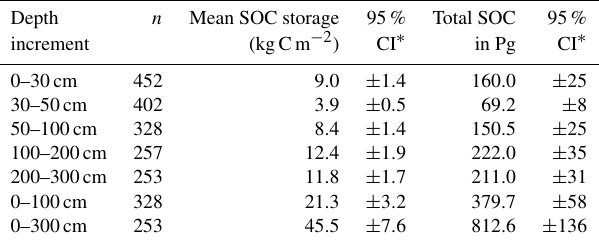
Table 4. Landscape mean and total SOC storage with 95% CI for the different depth increments for the northern circumpolar per- mafrost region, excluding water bodies and permanent snow and